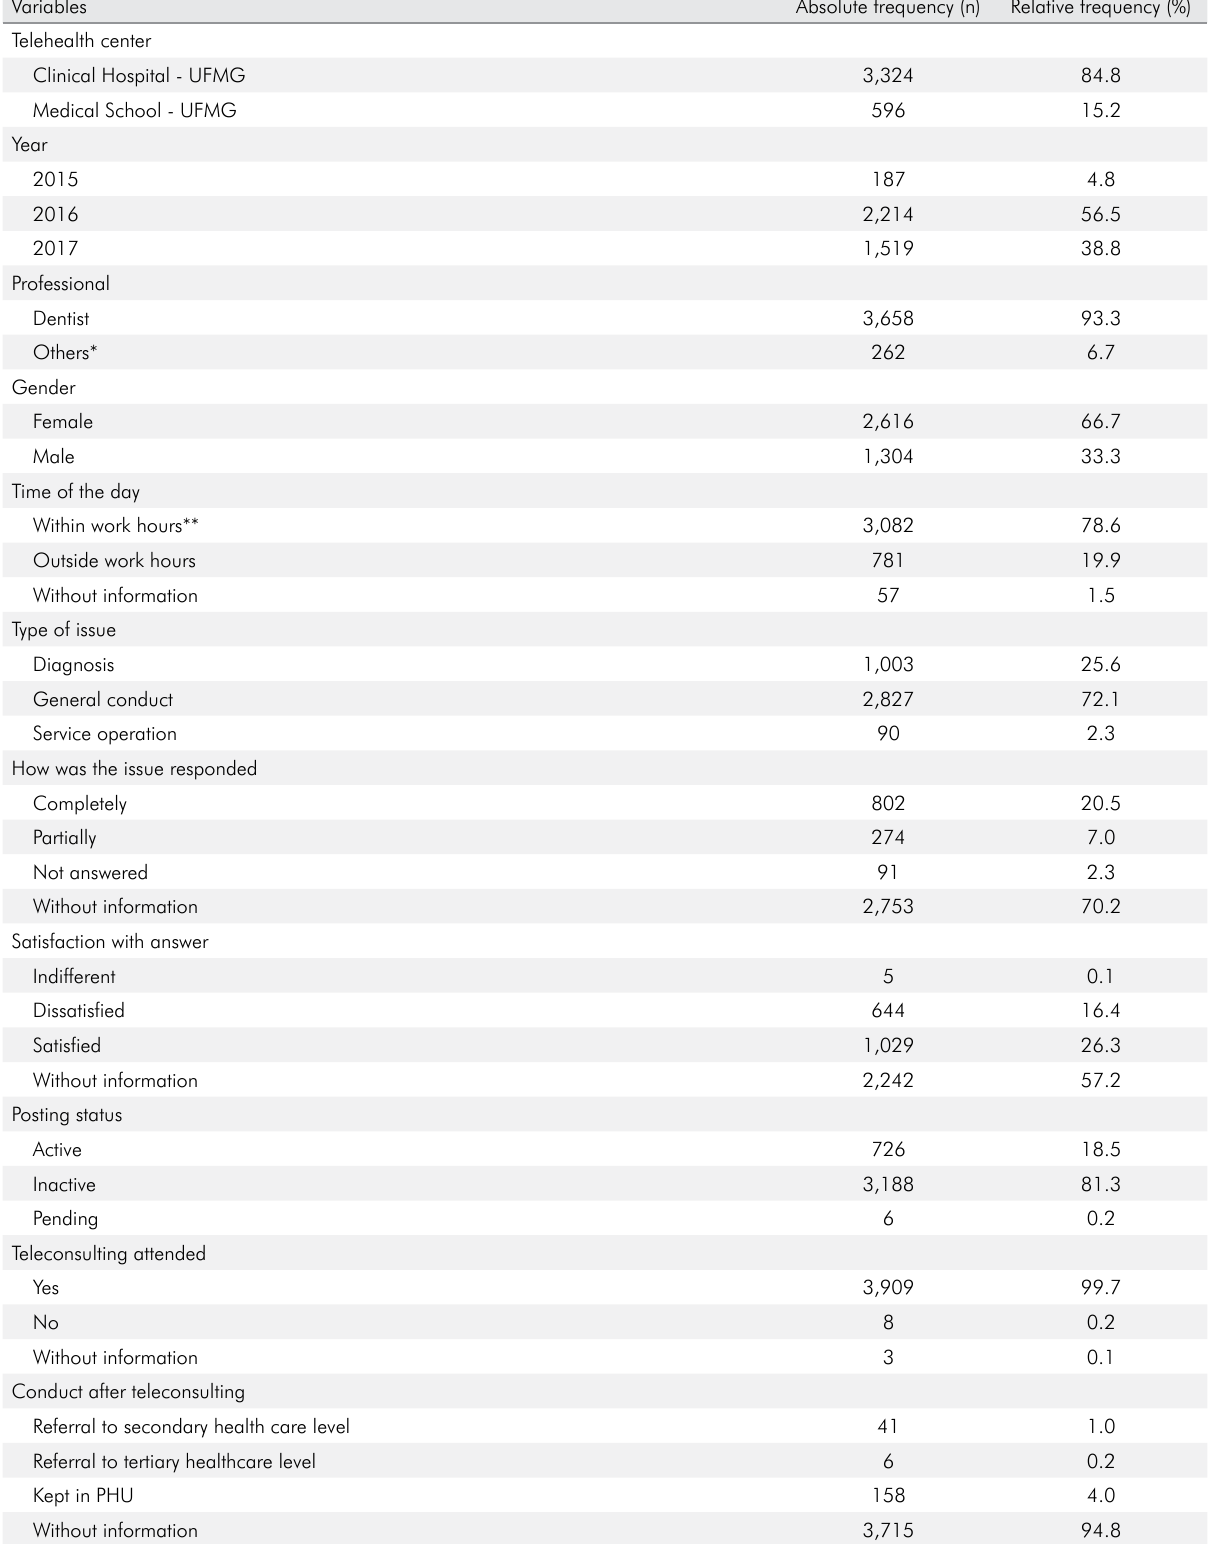
Table 1. Descriptive analysis of the dental Teleconsulting sessions carried out in Minas Gerais, Brazil in 2017.